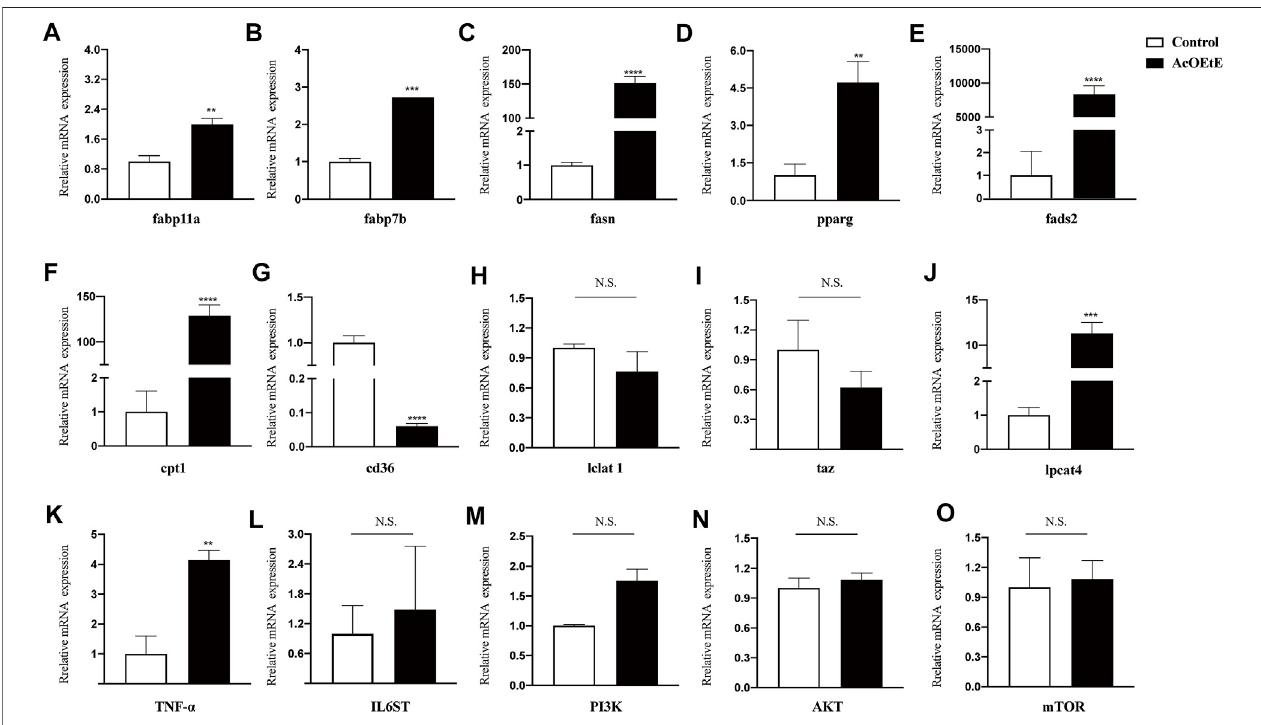
FIGURE 5 | Gene expressions after AcOEtE administration to zebra fi sh larvae were detected by qPCR. including (A) fabp11a (B) fabp7b (C) fasn (D) pparg (E) fads2 (F) cpt1 (G) cd36 (H) lclat1 (I) taz (J) lpcat4 (K) TNF- α (L) IL6ST (M) PI3K (N) AKT and (O) mTOR. All values are expressed as the mean ± SD of three or more independent experiments. *** p < 0.001; ** p < 0.01; * p <